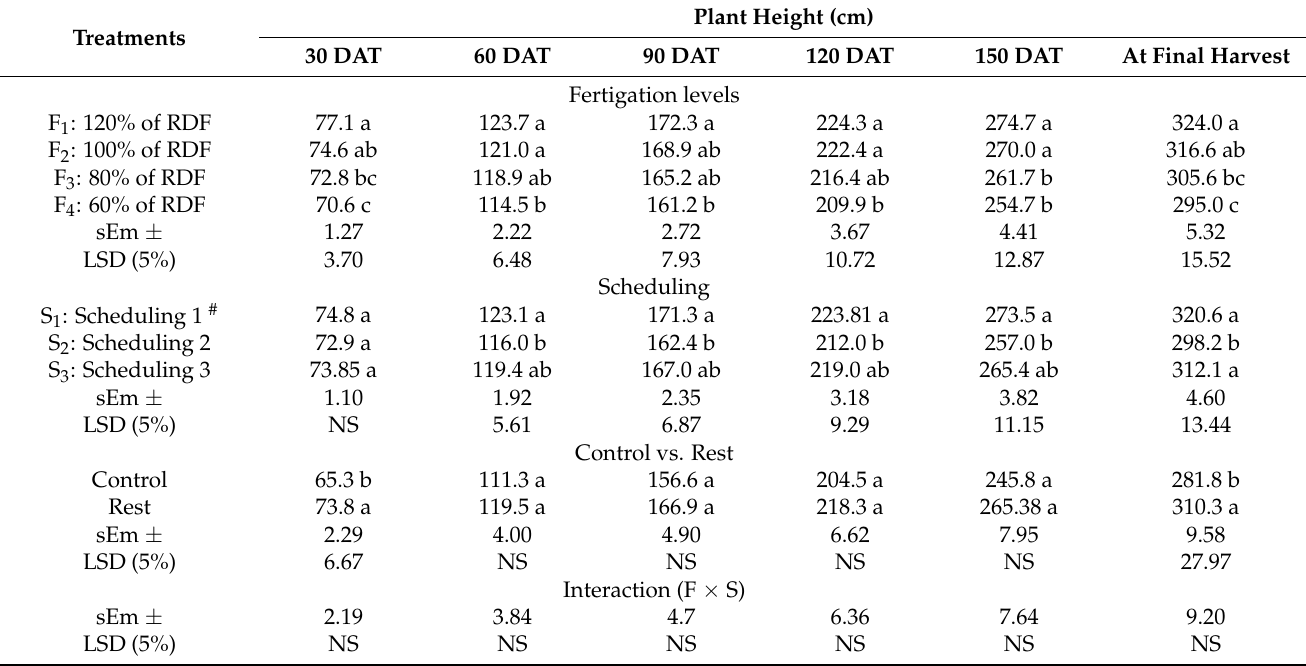
Table 3. Height of tomato plants as affected by fertigation levels and scheduling at different growth stages of tomato (2-years pooled